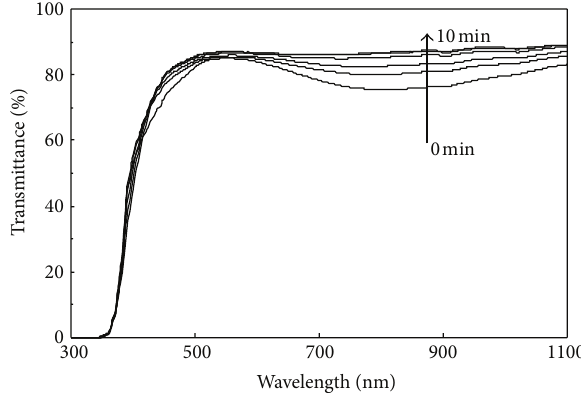
Figure 3: Transmittance spectra of CuCl 2 -urethane-resin compos- ite films (without AgCl) at UV-vis irradiation times of 0, 1, 2, 5, and